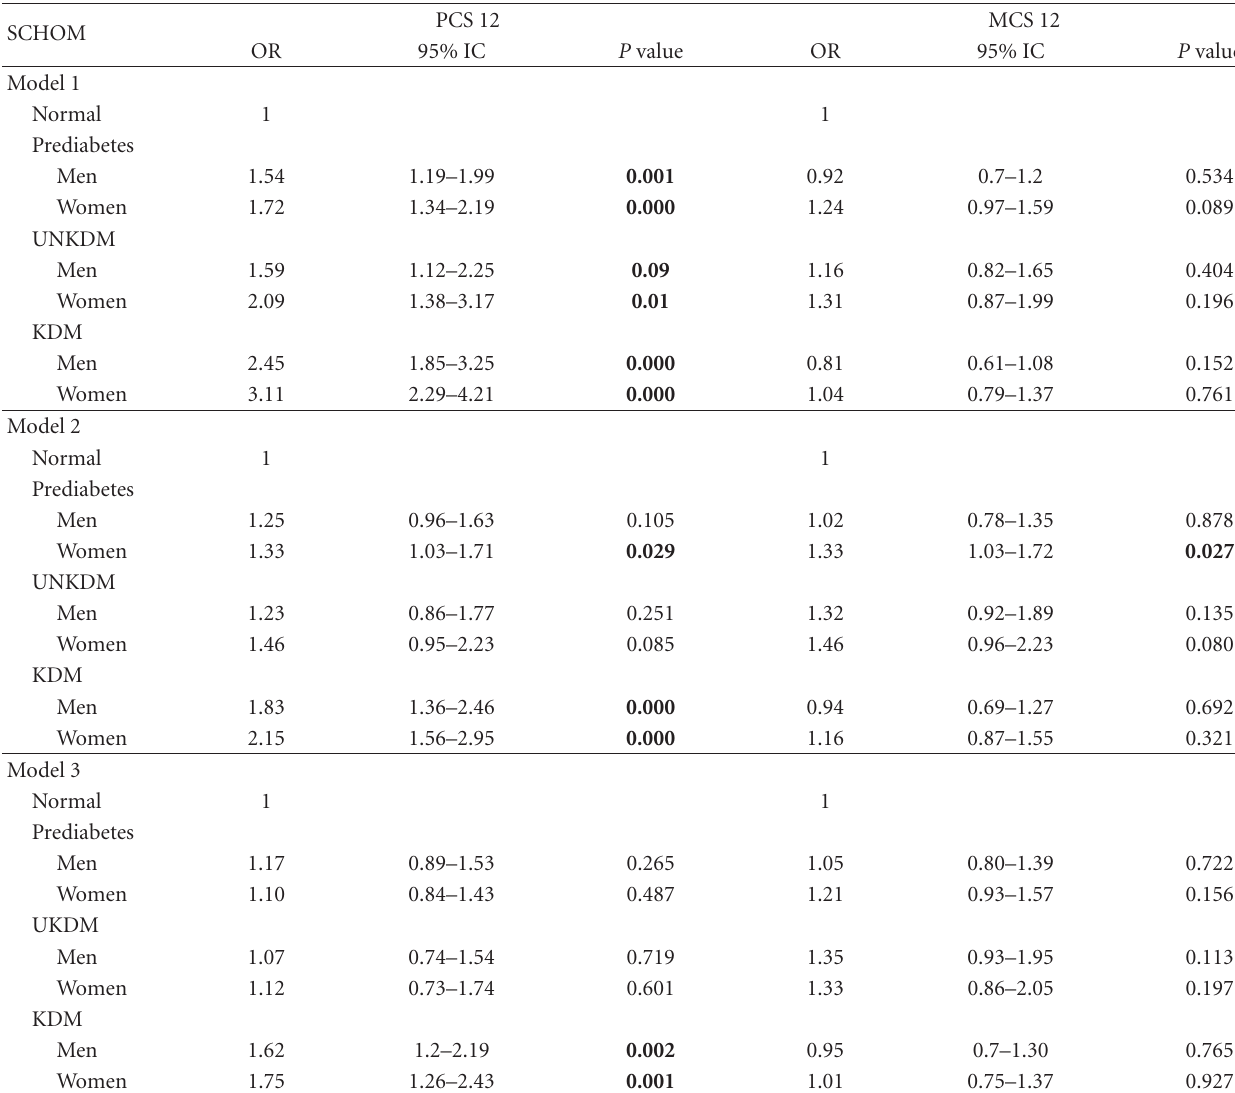
Table 2: Odds ratios for PCS 12 and MCS 12 scores lower than the median (Model 1) adjusted for age (Model 2), and adjusted for age, educational level, and BMI, all stratified by gender (Model